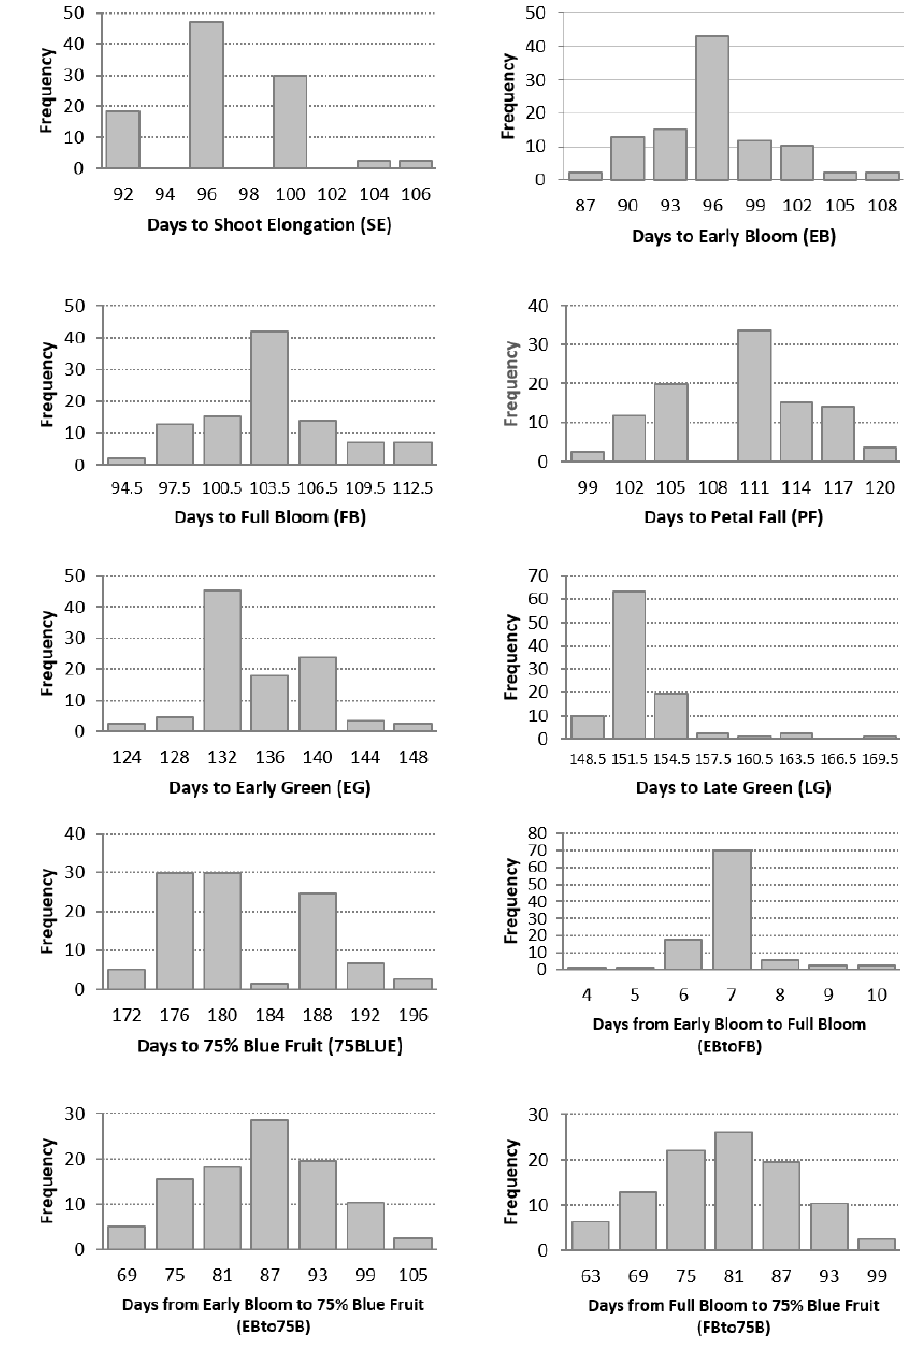
Figure 1. Distribution of the growth stage traits in the diploid blueberry population. Frequency is shown on the y-axis, and Julian day or days between two stages is shown on the x-axis.